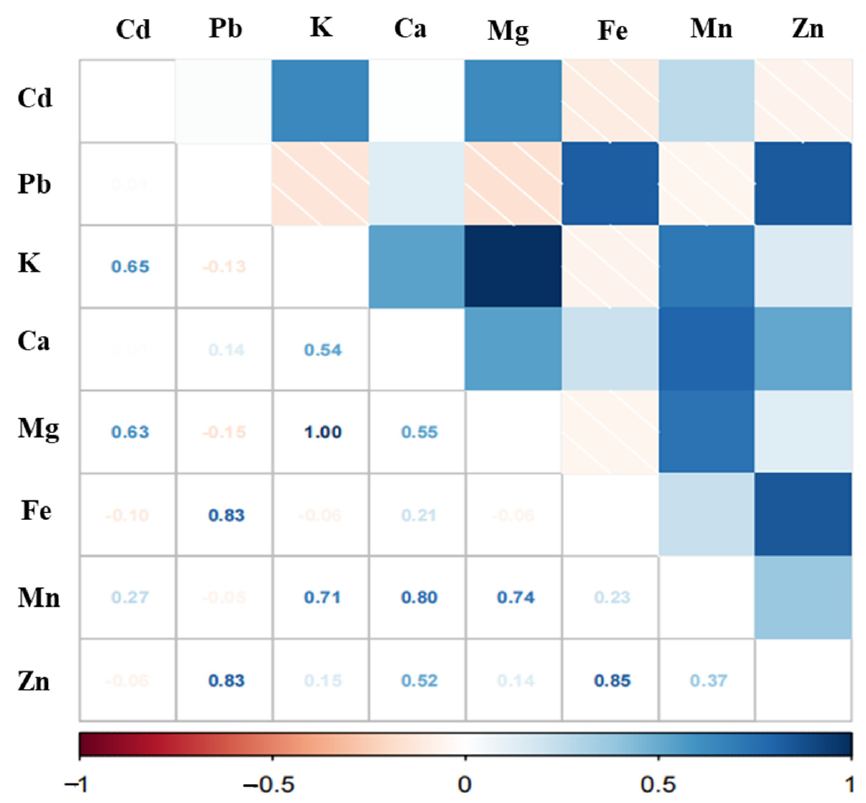
Figure 3. The correlation between elements in rice with different polishing degrees.